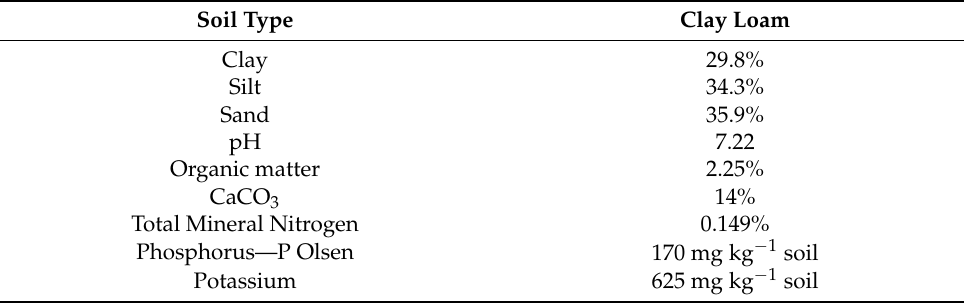
Table 4. Soil properties of the experimental field.